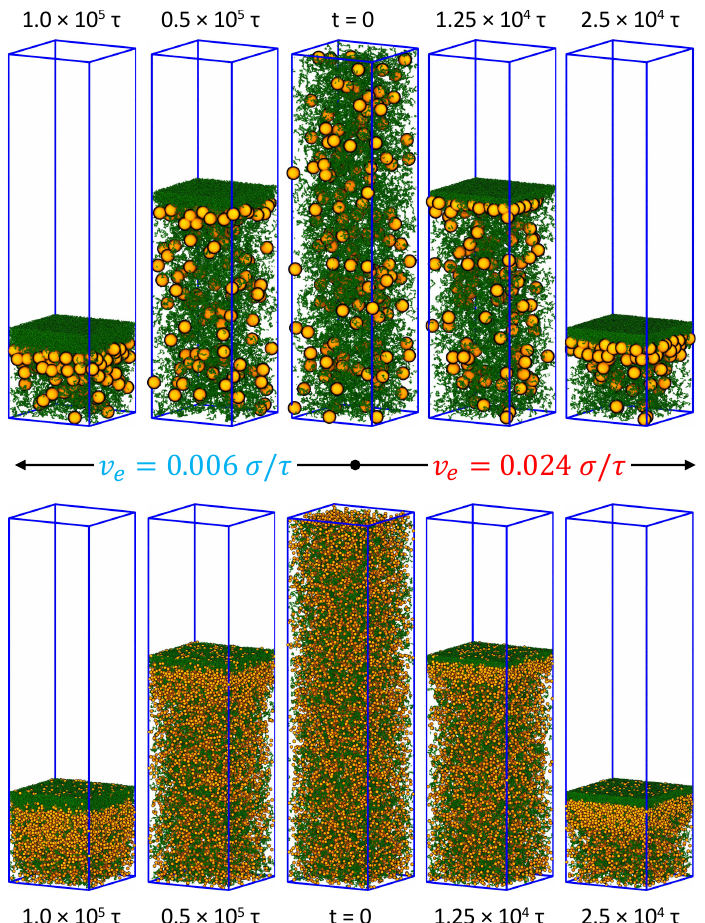
Figure 1. Snapshots of solutions of nanoparticles (orange) and polymer chains (green) at various stages of drying for different evaporation rates: ( left ) v e = 0.006 σ / τ and ( right ) v e = 0.024 σ / τ ; ( top ) the polymer-MNP mixtures and ( bottom ) the polymer-SNP mixtures.